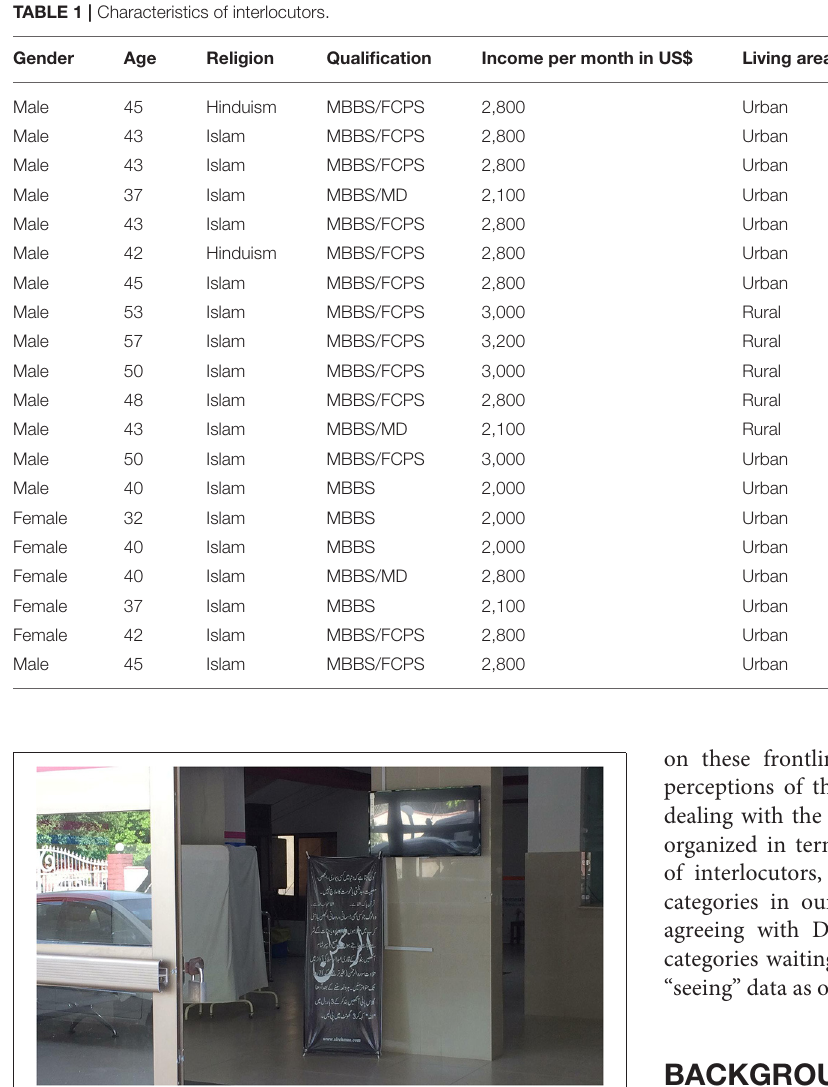
FIGURE 1 | A banner at the entrance of COVID-19 ward containing the Urdu translation of a Quranic